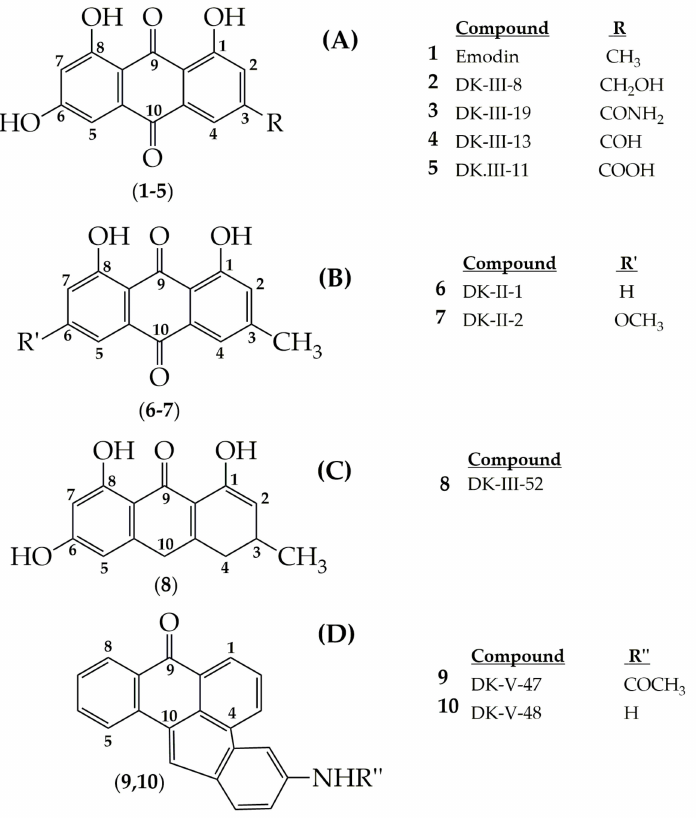
Figure 4. Chemical structures of emodin and its